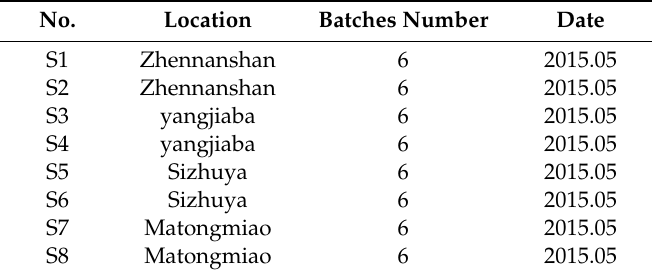
Table 7. The sources of